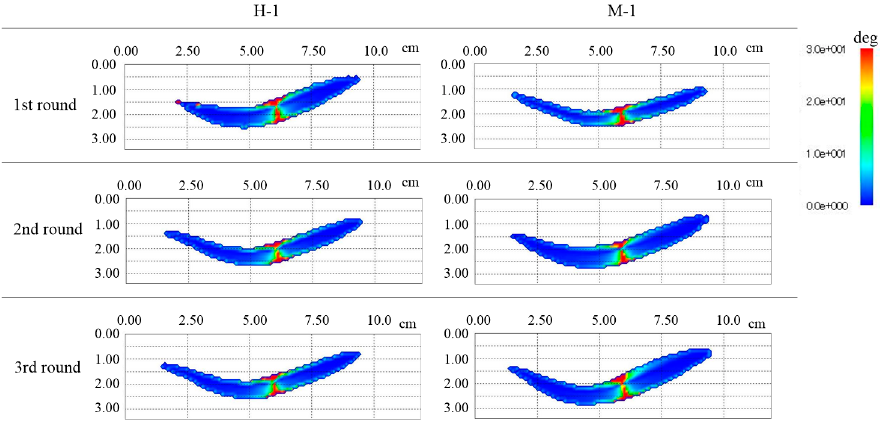
Figure 19. Distribution of the internal friction angle from the simulation results.